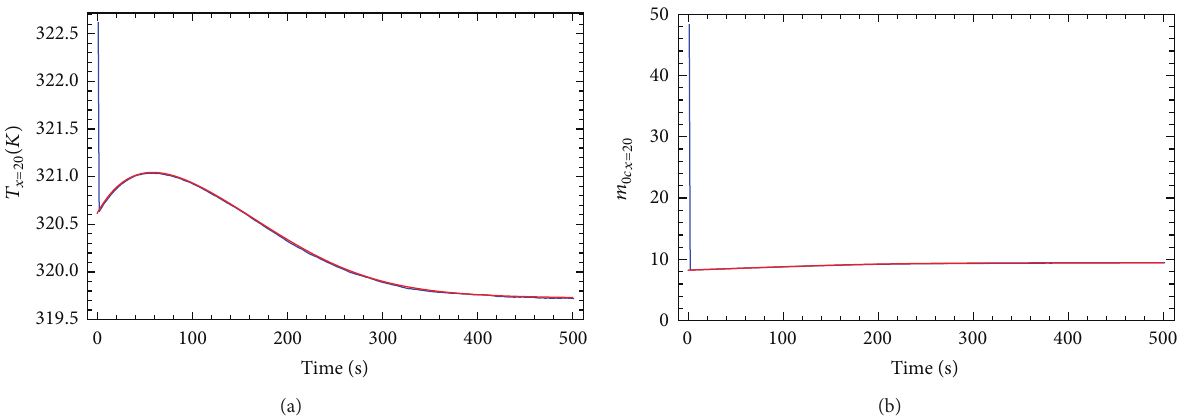
Figure 11: States (red) and estimates (blue) at the first drying zone’s exit.